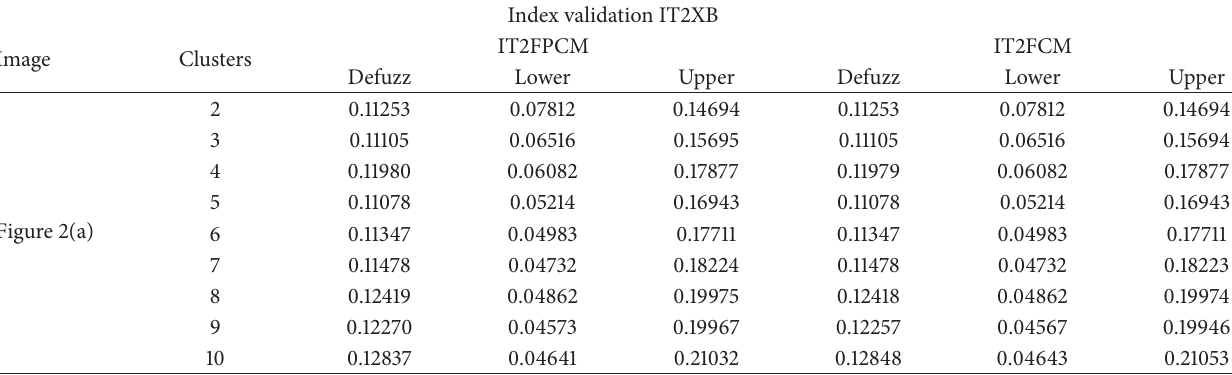
Table 27: Results of the IT2XB validation index for data clustering of image shown in Figure 2(a) using IT2FPCM and IT2FCM algorithms with 𝑚 = [1.5, 2.5] and 𝜂 = [1.5, 2.5] as